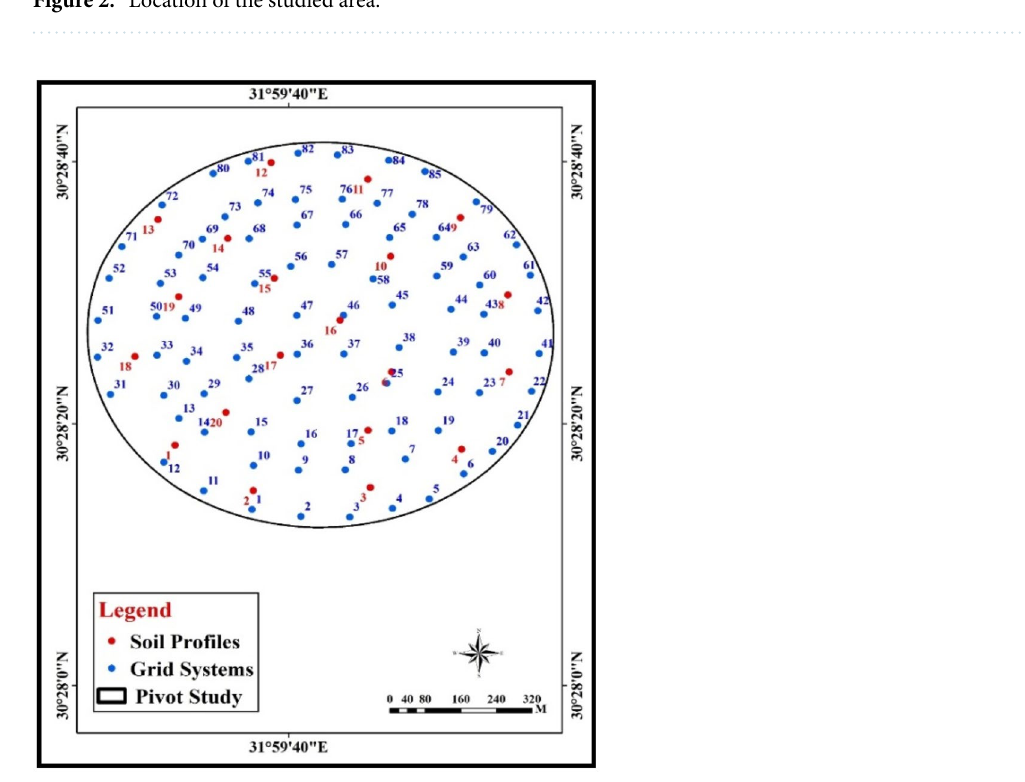
Figure 2. Location of the studied area.